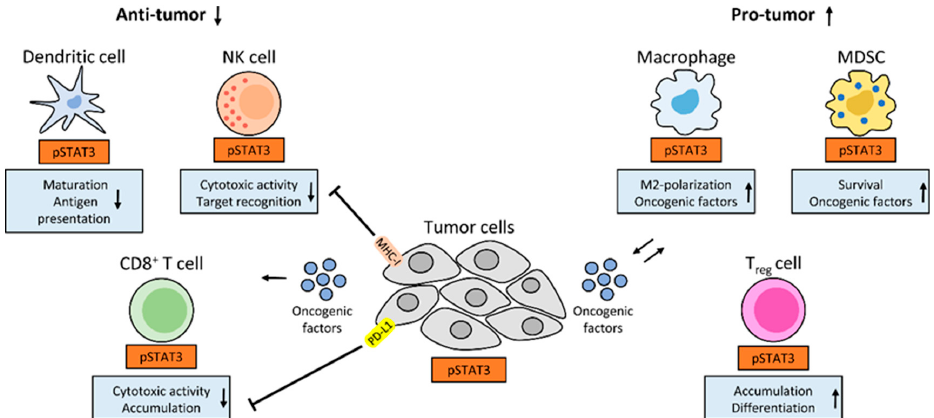
Figure 2. A central role for STAT3 in anti-tumor immunity and inflammation: Tumor cell-intrinsic STAT3 drives the expression of oncogenic factors (e.g., IL-6, IL-10 or VEGF), which can activate STAT3 in immune cells and enhance their recruitment to the TME (middle). STAT3 activity in NK and CD8 + T cells impairs their cytotoxic activity, while STAT3 activity in dendritic cells hampers their maturation and capability to present antigens. Tumor cell-intrinsic STAT3 drives MHC class I